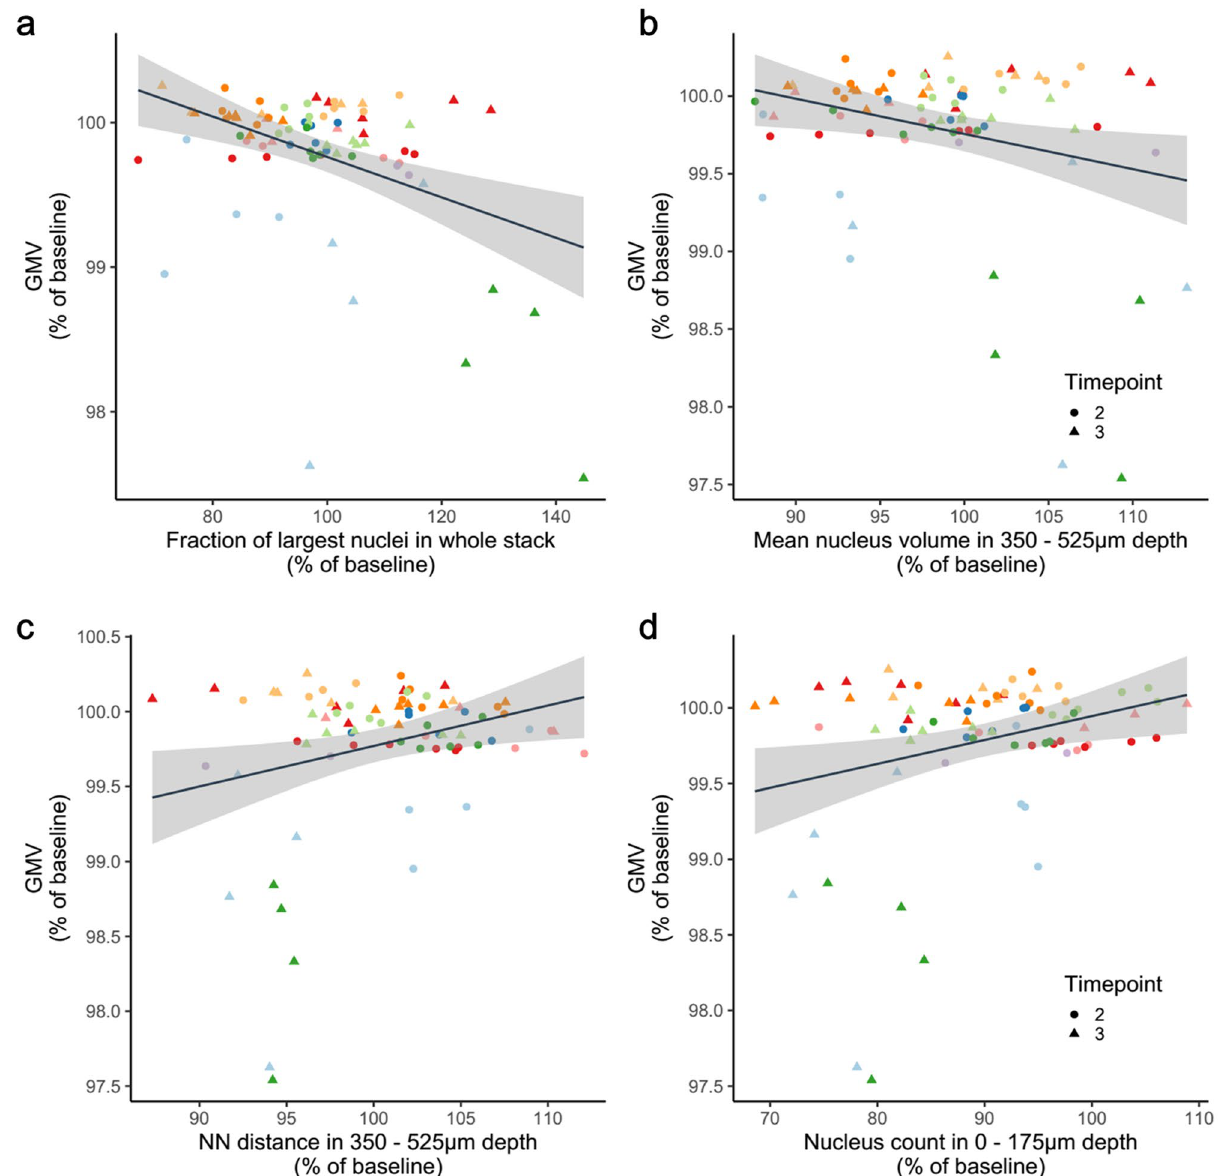
Figure 8. Factors found to significantly influence GMV. At 1 week: n = 45 positions from 9 mice; at 12 weeks: n = 35 positions of 7 mice; Linear mixed models. ( a ) Correlation between the change in fraction of largest nuclei (2250–3000 µm 3 ) within the whole stack and the respective JD p = 0.0001, R 2 = 0.130, Estimate = − 0.013%. ( b ) Correlation between relative change in mean nucleus volume within a depth of 350–525 µm and the JD; p = 0.0005, R 2 = 0.0964, Estimate = − 0.027%. ( c ) Correlation between nearest neighbour distance changes within a depth of 350–525 µm and the JD. p = 0.002, R 2 = 0.087, Estimate = 0.030%. ( d ) Correlation between the change in number of nuclei within a depth of 0–175 µm and the respective JD; p = 0.021, R 2 = 0.044, Estimate =